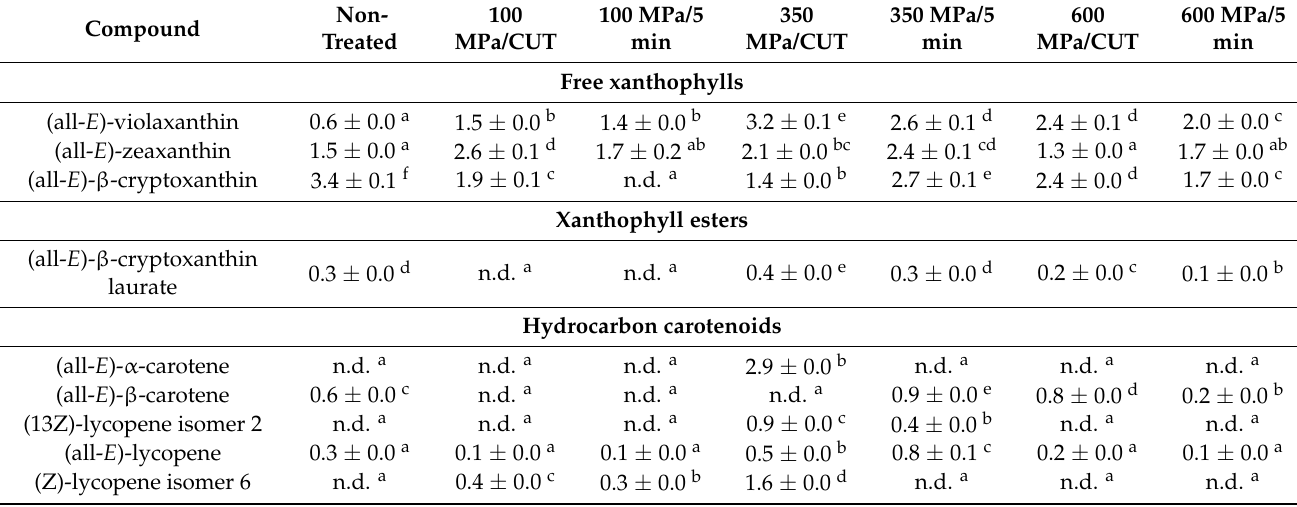
Table 3. Carotenoid bioaccessibility (%) 1 after in vitro simulated gastrointestinal digestion of Sweet Mary papaya ( Carica papaya L.) variety submitted to HHP treatments (100, 350 and 600 MPa at CUT and 5 min). Non- 100 Compound Treated